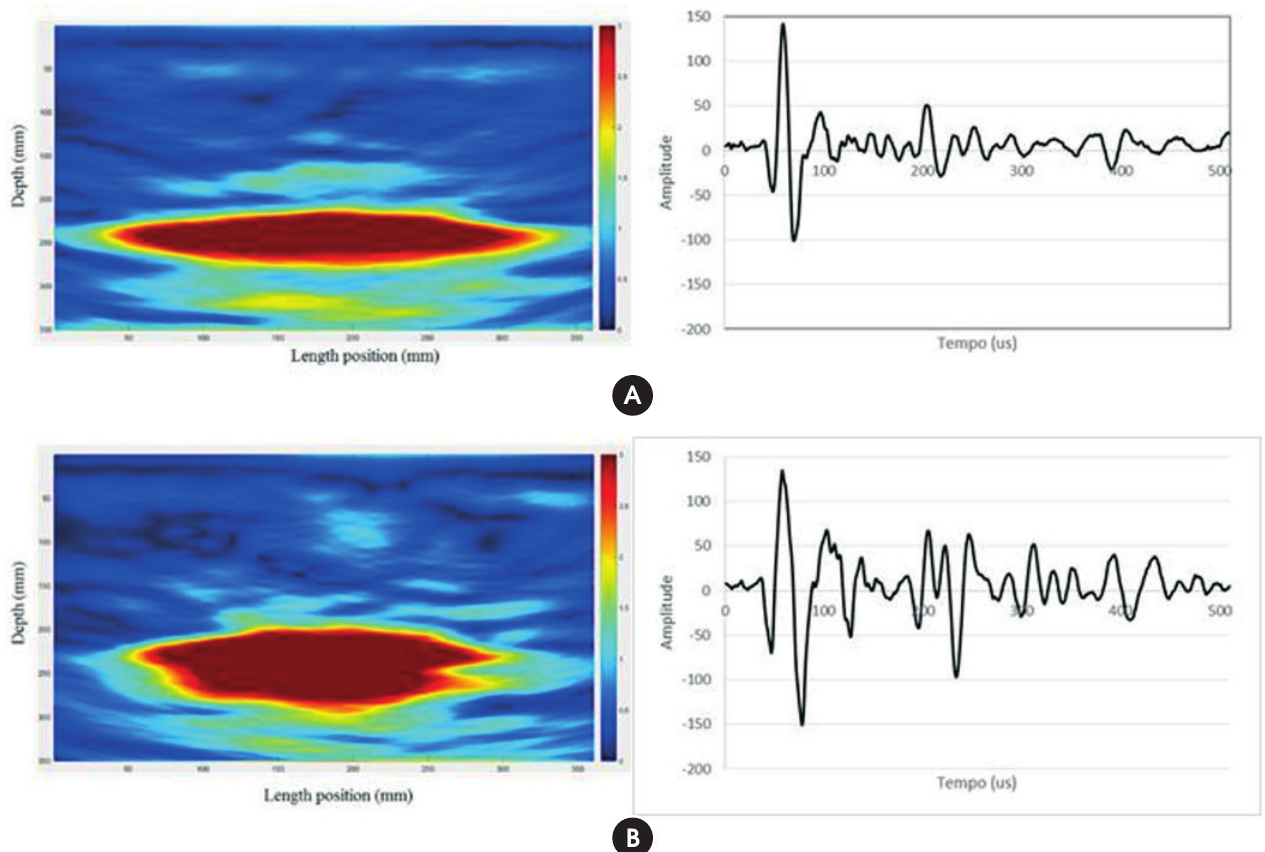
Differences in signal amplitude for sound (a) and damaged (b)